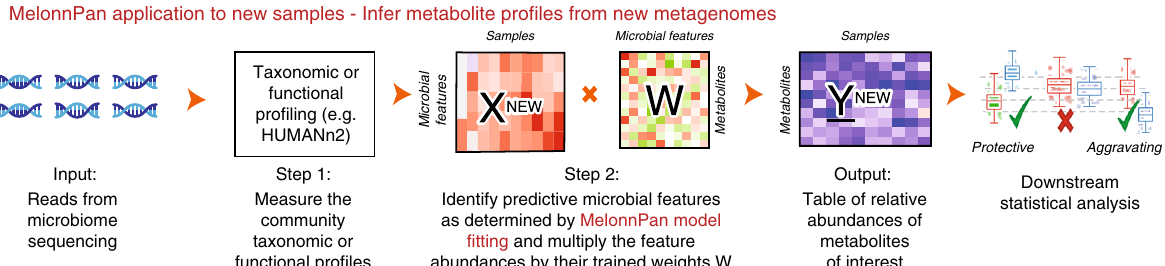
Table of paired sequence features and metabolite abundances of microbial communities